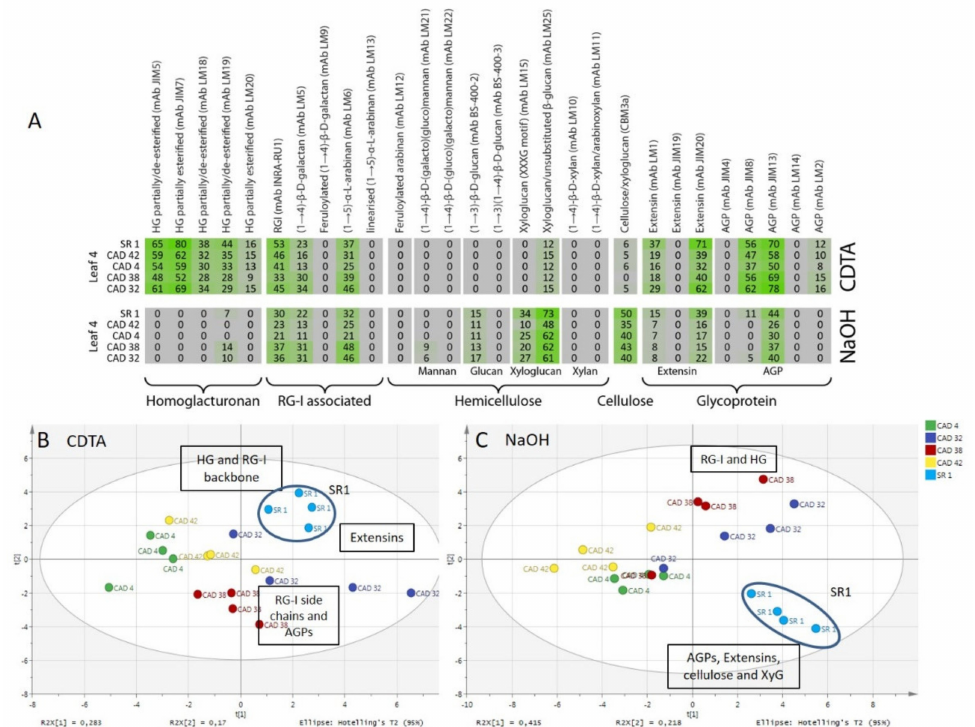
Figure 5. CoMPP of the leaf 4 AIR from SR1, CAD42, CAD4, CAD38, and CAD32 tobacco lines. ( A ): Heatmap showing cell wall polysaccharides and proteins relative abundance using antibodies signal intensity reads, presented results are the average of four biological repeats. ( B ): PCA of the pectin-rich fraction (CDTA) and ( C ): PCA of the hemicellulose-rich fraction (NaOH). On the PCA, samples are coloured according to their genotype. The wild type SR1 samples are highlighted and circled. Data obtained from four biological